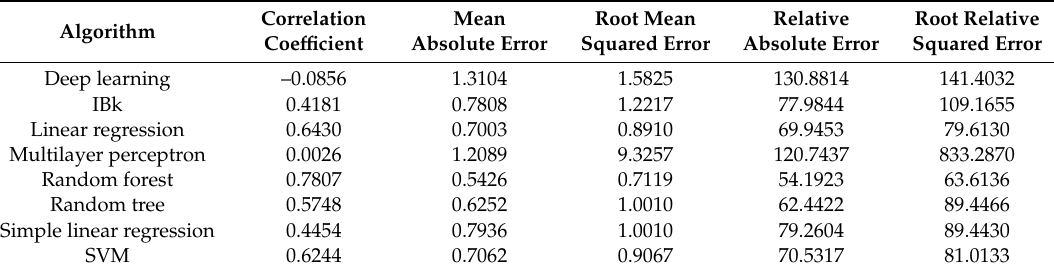
Table 2. Error measures from eight regression algorithms classifying data into four classes.